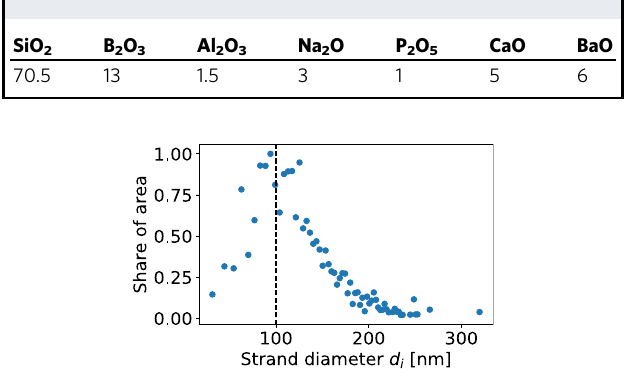
Table 1 Phase-separated glass composition in weight %.